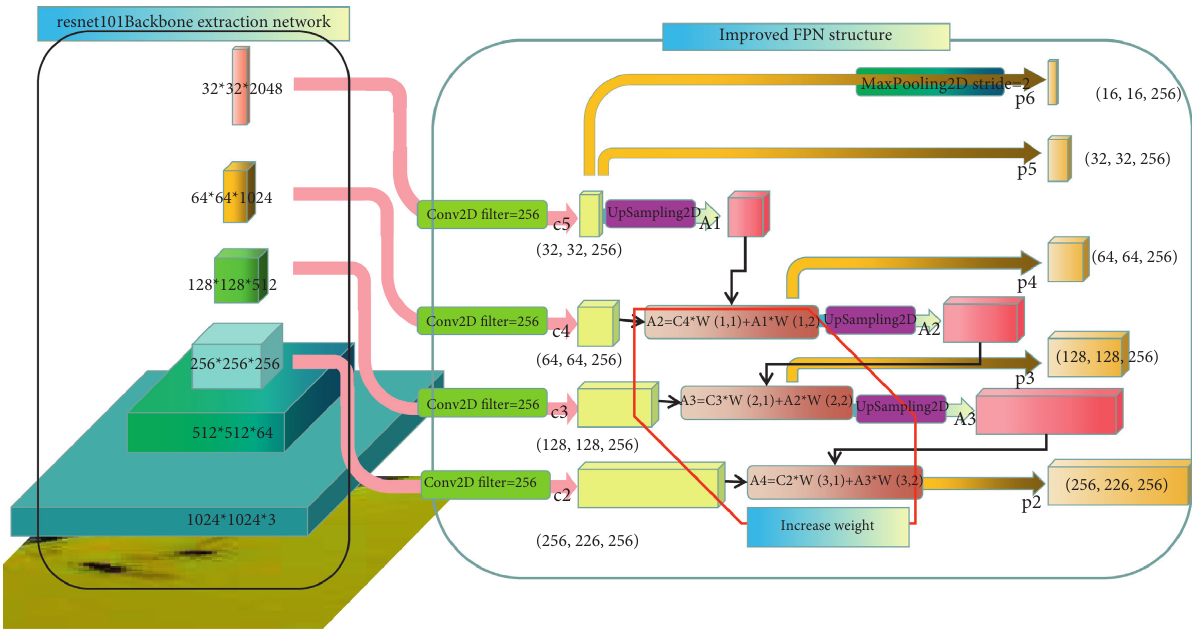
Figure 4: Improved ResNet-101-FPN